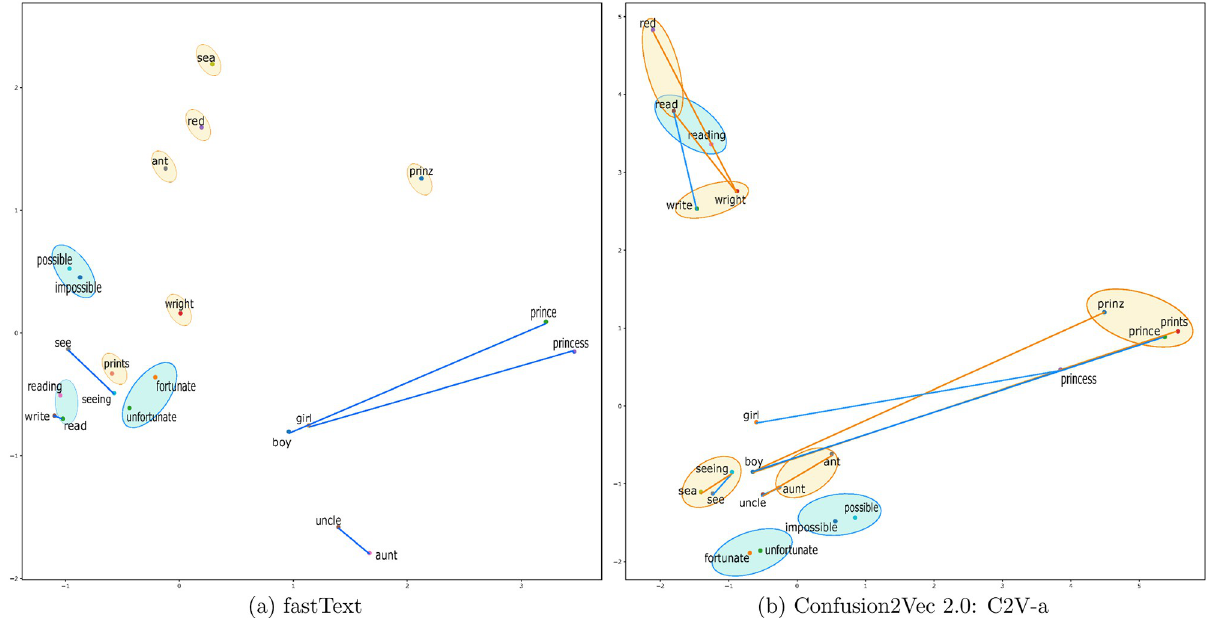
Fig 2. 2-D plots of selected word vectors portraying semantic, syntactic and acoustic relationships after dimension reduction using PCA. The blue lines indicate semantic relationships, blue ellipses indicate syntactic relationships, orange lines indicate acoustic-semantic/syntactic relations and orange ellipses indicate acoustic ambiguity word relations. Plots with identical word sets corresponding to Confusion2Vec 1.0 and Google W2V can be found in [11]. Please note that the out-of-vocabulary word “prinz” cannot be represented in Google W2V and Confusion2Vec 1.0 spaces.